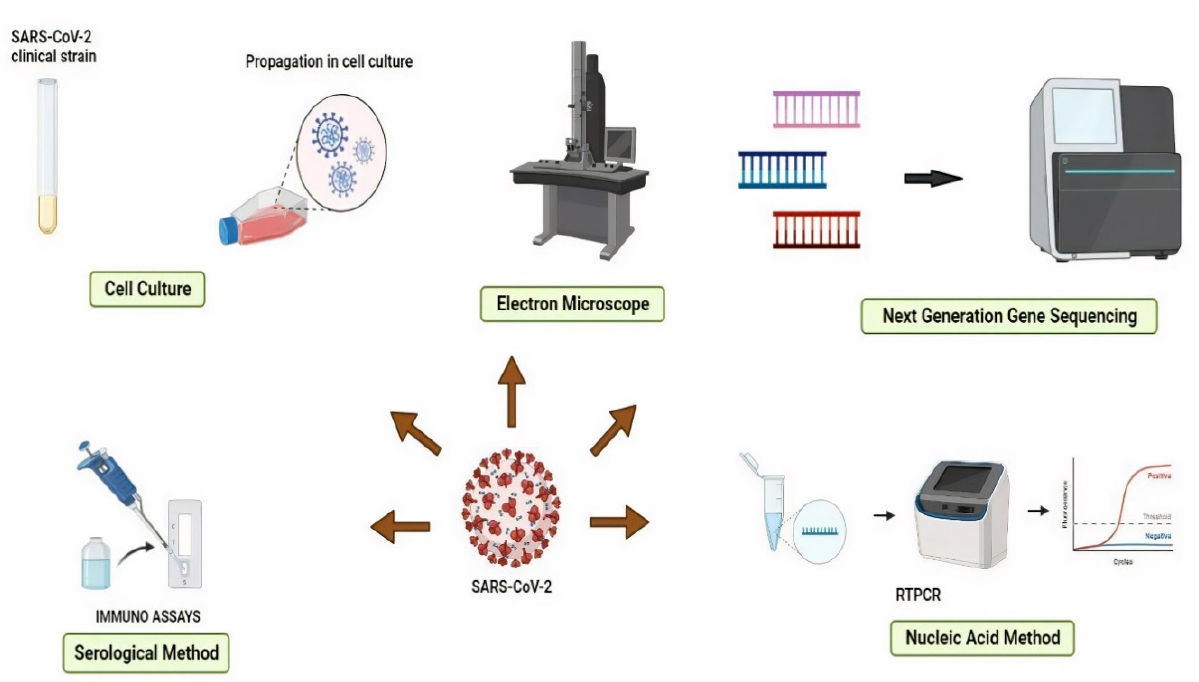
Figure 2. Methods for detecting RNA viruses.